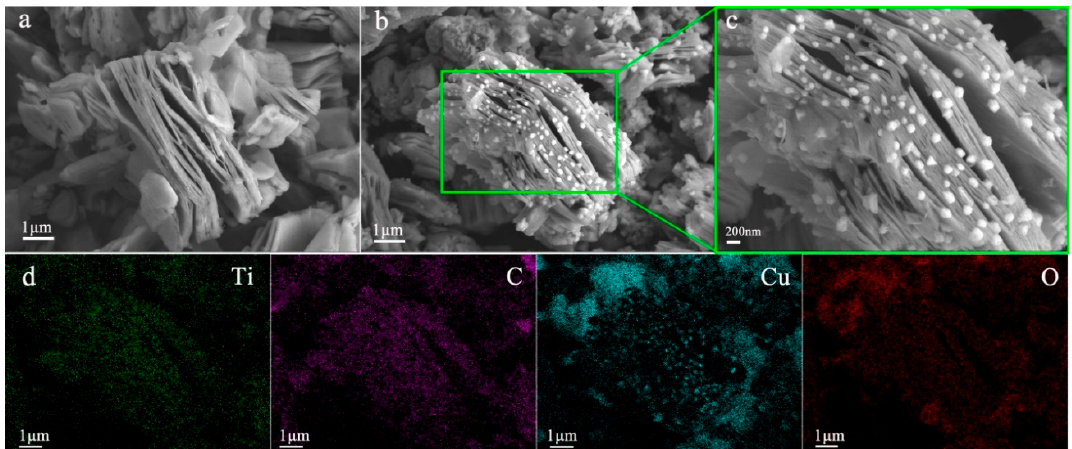
Figure 3. Field-emission scanning electron microscopy (FESEM) images of MXene ( a ), MXene/50% CuO nanocomposite ( b , c ), and elemental mapping results ( d ).